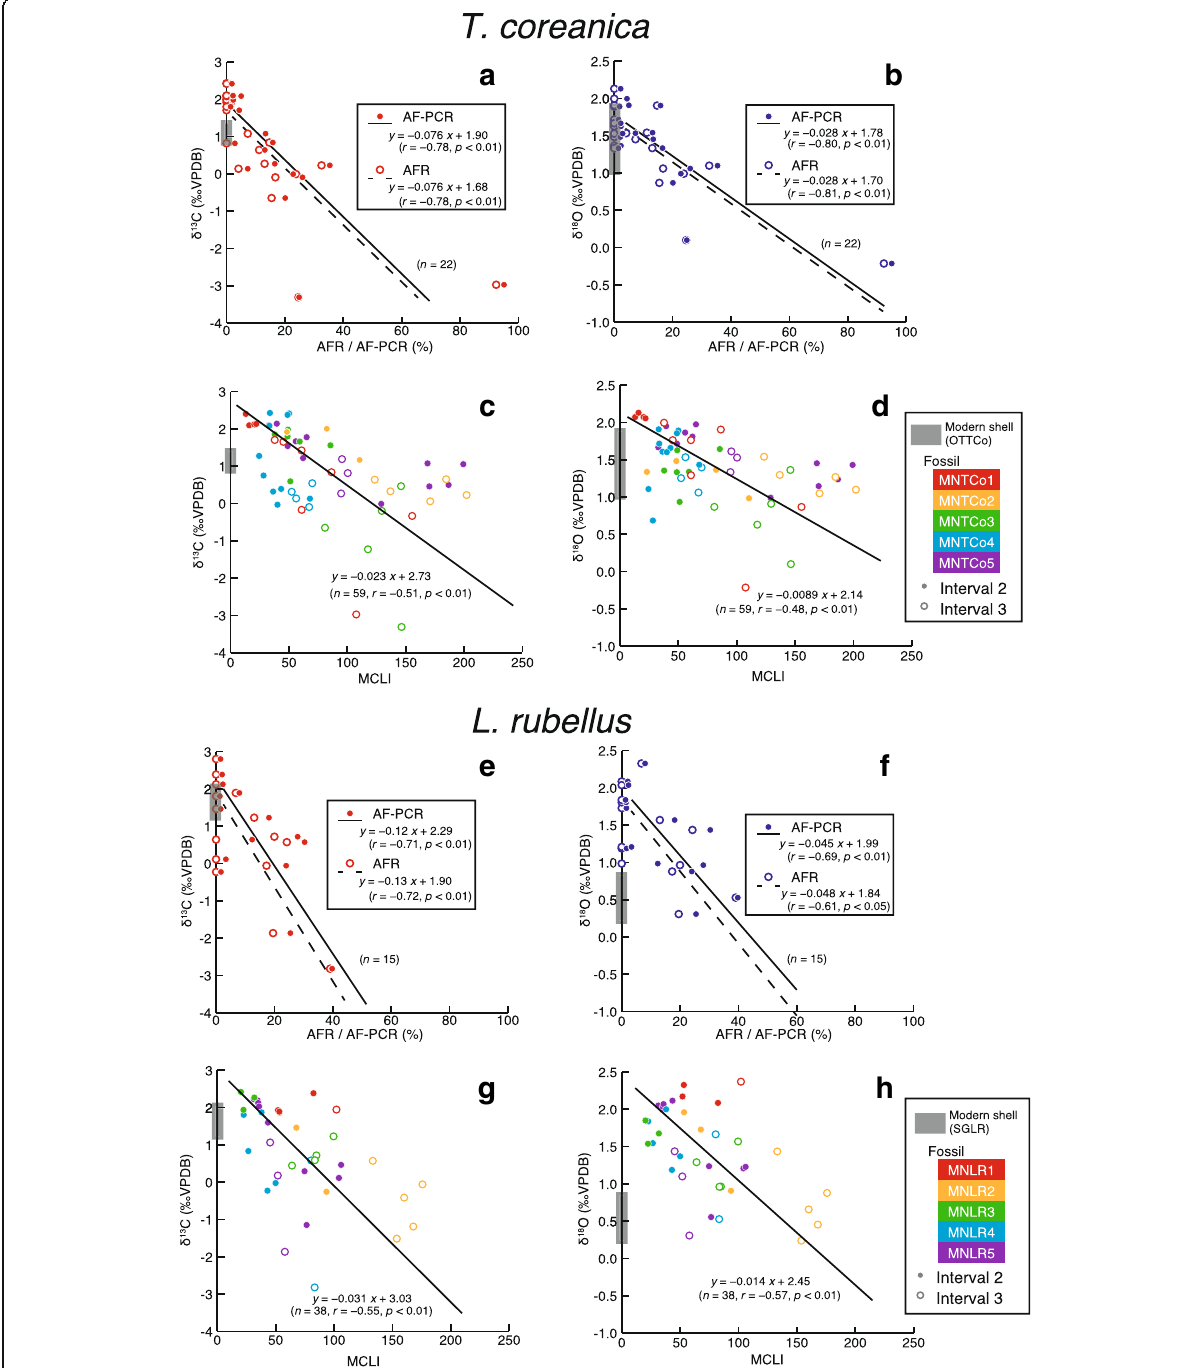
Fig. 10 Cross-plots of isotopic composition versus AFR or AF-PCR ( a , b , e , and f ) and of isotopic composition versus MCLI ( c , d , g , and h ) . The gray bar on the y -axis indicates a range of δ 13 C or δ 18 O values of the modern brachiopod shell (OTTCo or